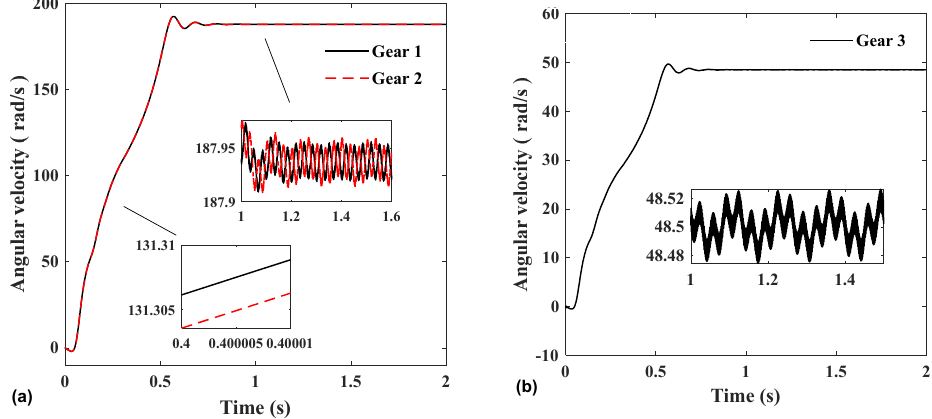
Figure 9. ( a ) Angular velocities of gears 1 and 2. ( b ) Angular velocities of gear 3.